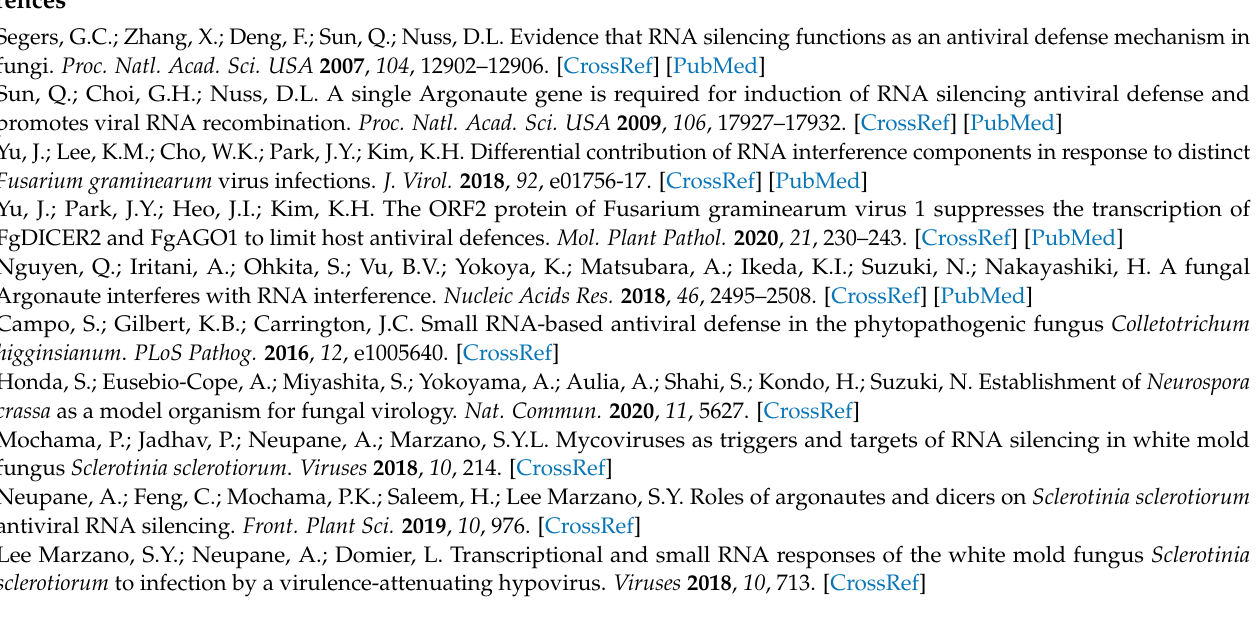
Figure S2: Instable MyRV2 infection in strain C18 transformed with an empty vector, Figure S3: Quantitative analyses of dcl2 or MyRV2 S4 mRNA in C18 transformed by the empty vector and p24 coding domain. different fungal strains, Figure S4: Quantification of dcl2 or MyRV2 S10 mRNA in different fungal strains. Bar graphs show the relative accumulation levels (mean ± SD, n = 2–5) of dcl2 or MyRV2 S10 mRNA based on the northern blotting data shown in Figure 4. Table S1: List of primers used for analyzing CHV4-C18 RNA silencing